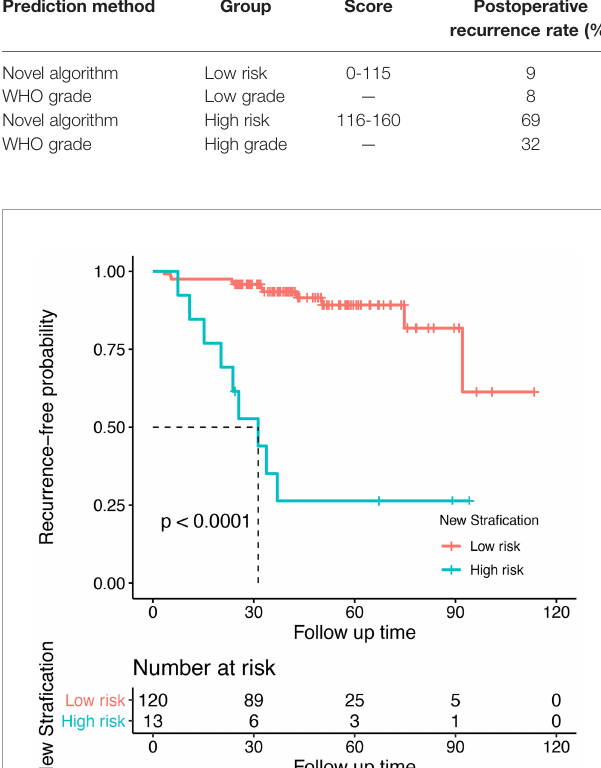
TABLE 2 | Postoperative recurrence in each group of the novel algorithm and WHO grade. Prediction